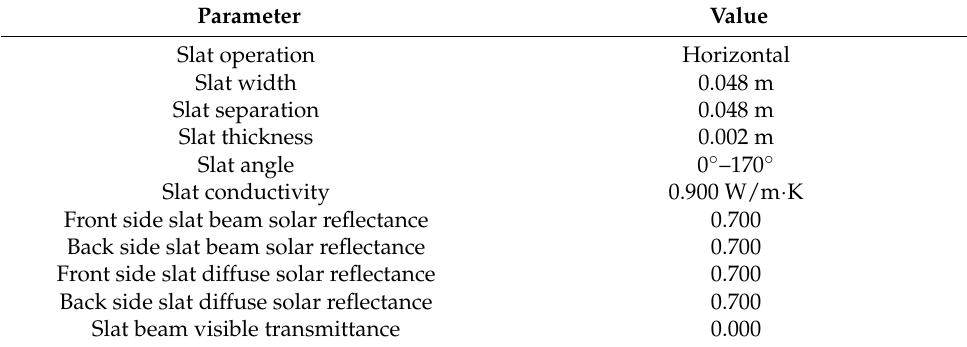
Figure 3. Diagram of movable shading device integrated with the photovoltaic (PV) at various slat angles. Table 3. Shading device input variables.